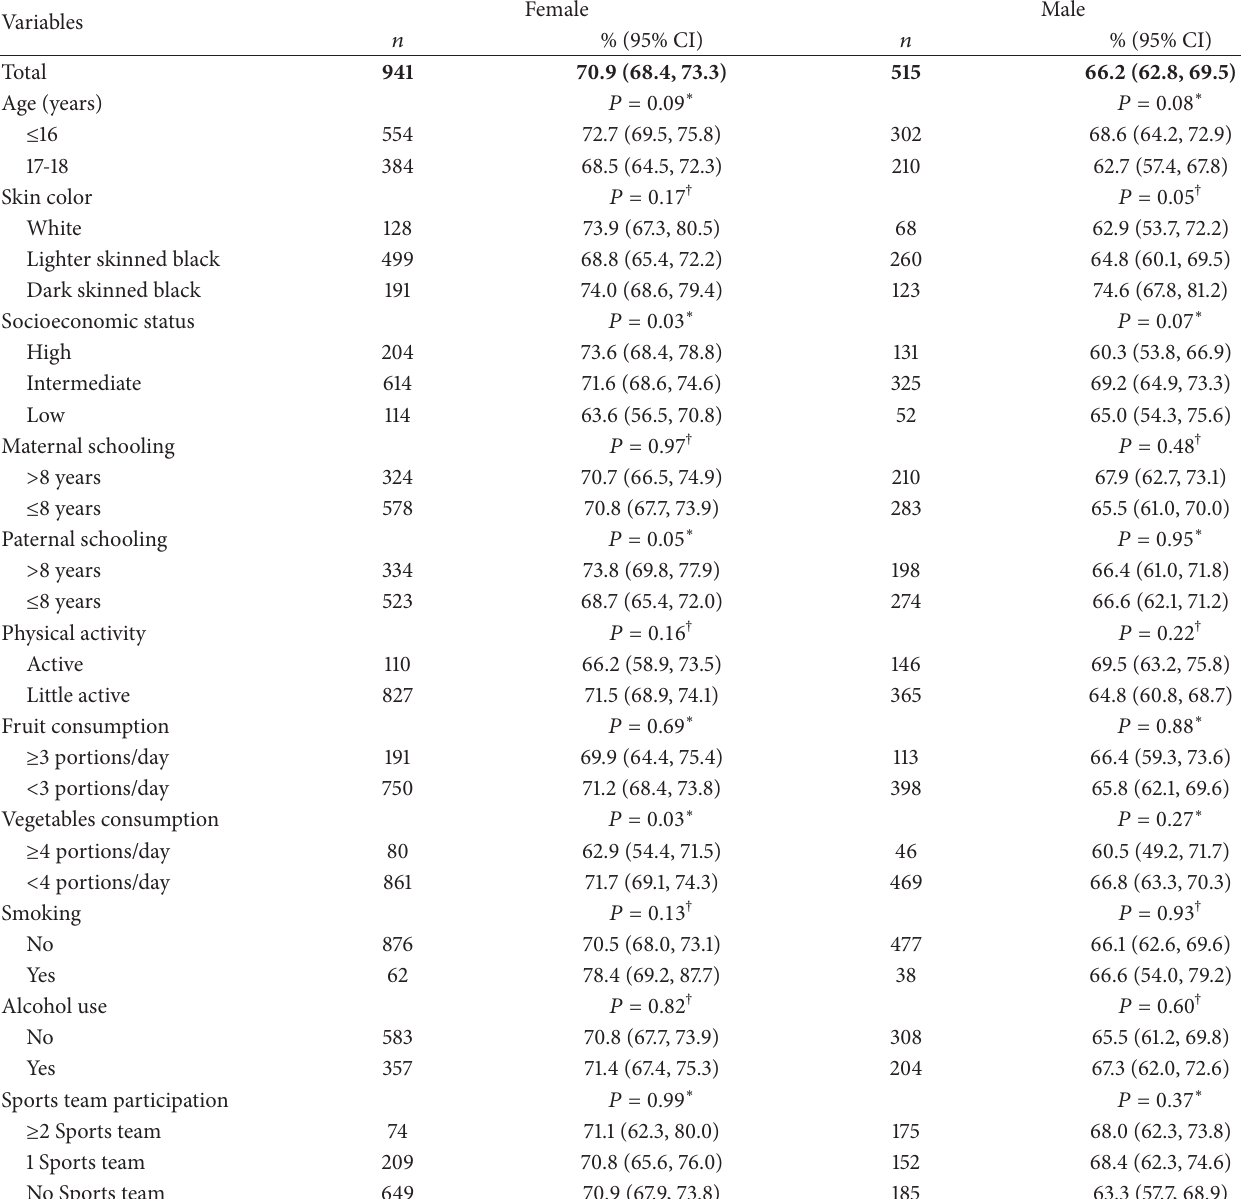
Table 2: Prevalence of excess television time ( ≥ 2 hours/day) according to independent